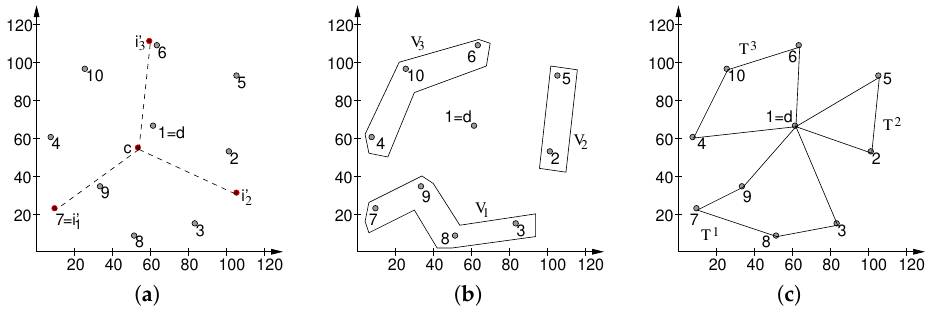
Figure 12. Phases to construct a solution for an instance of the bounded MTSP with k = 3, m min = 2 and m max =